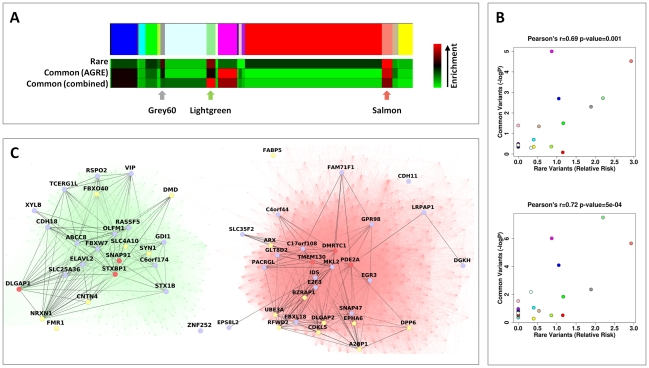
Rare and common variations in ASD perturb shared neuronal modules.(A) Color map showing the different modules in the WGCNA analysis. Below it, heat maps depicting, for each module, the relative risk (RR) for harboring genes with rare mutations (top), the enrichment for low GWAS p-values in the AGRE cohort (center) and the combined enrichment for low GWAS p-values across the three GWAS (bottom). The intensity of the red hue corresponds to higher enrichment of common or rare variants. (B) For each module, the enrichment for low GWAS P-values (−log10
P) in the AGRE cohort (top) or combined across the three cohorts (bottom) is plotted against the relative risk for rare mutations. The color of the points corresponds to the names of the modules. (C) The connections in the two neuronal modules enriched for common and rare variations, Lightgreen (left) and Salmon (right), are visualized. Three highly connected genes in each module (hub genes) are shown in red; genes with a gene-wide p-value<0.05 in light blue, and genes with known rare mutations in autism in yellow.